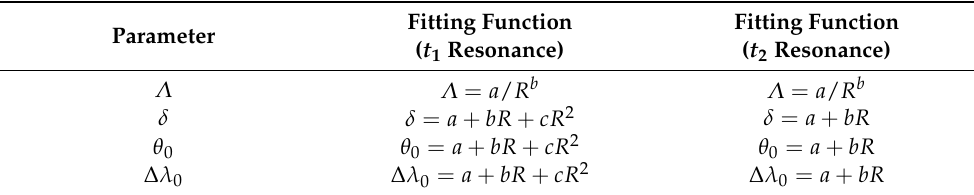
representative fitting constants).